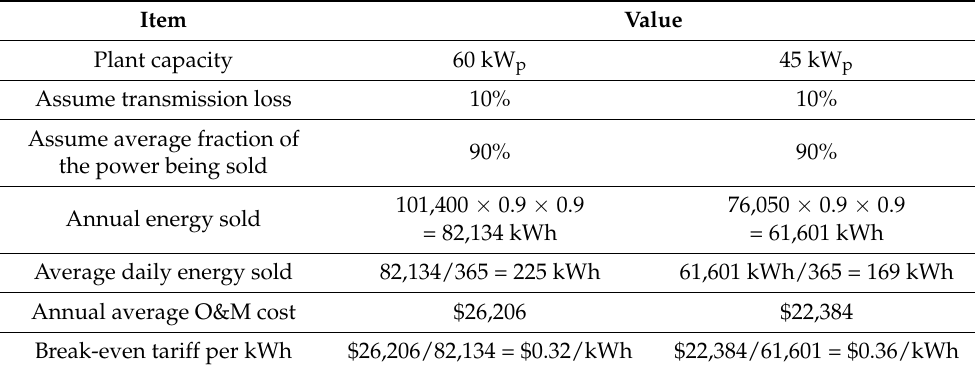
Table 7. Annual energy generated and break-even tariff estimation for Mpanta